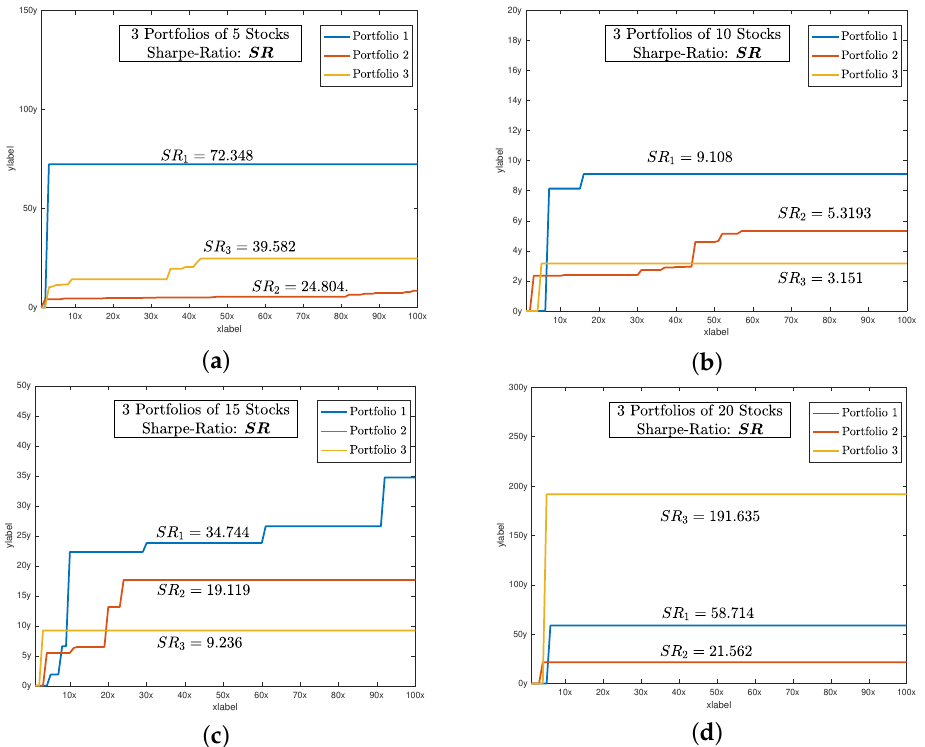
Figure 7. The rising trend of Sharpe ratio SR as the DBAS moves towar the optimal solution of portfolio selection problem. The higher value of SR indicates that each portfolio has a higher profit ξ ( E ) and lower risk υ ( E ) , as shown in (23). ( a ) shows the convergence profile of sharpe-ratio of 5 stocks. Likewise, ( b ) shows the convergence of sharpe-ratio of 10 stocks. And finally, ( c , d ) shows the convergence of sharpe-ratio of 15 and 20 stocks respectively.